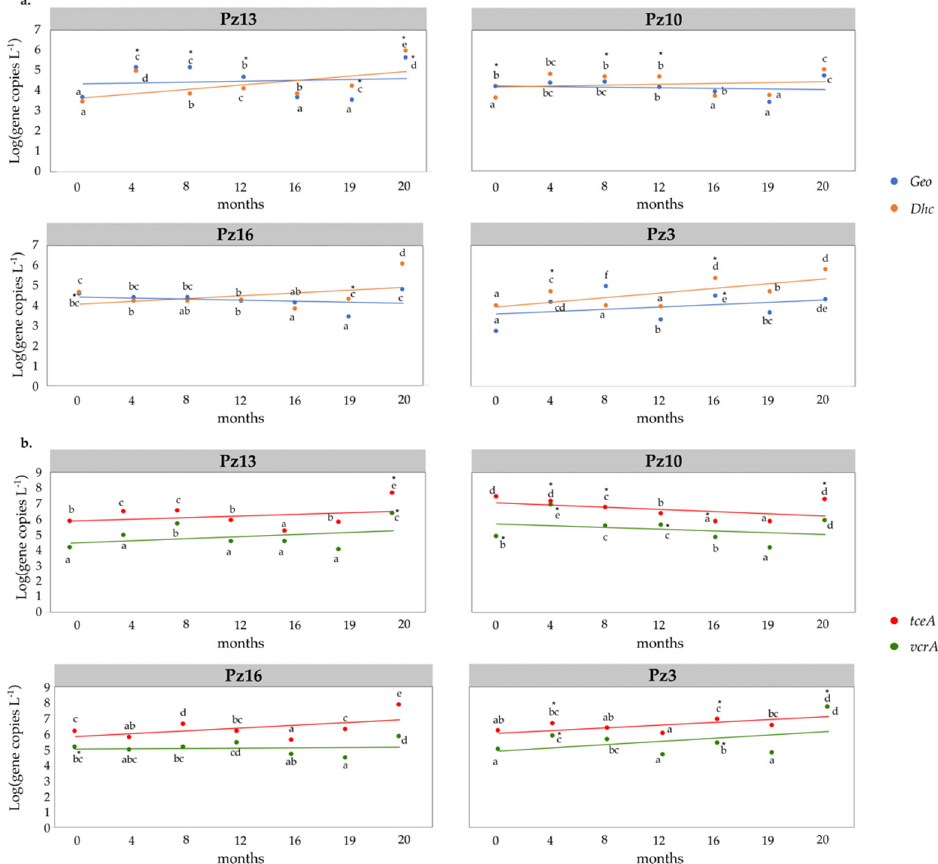
Figure 5. Gene copy abundance of phylogenetic gene markers for Geobacteraceae ( Geo ) and Dehalococcoides ( Dhc ) ( a ) and functional gene markers ( tceA and vcrA ) ( b ) in Pz13, Pz10, Pz16 and Pz3 during time. * indicates significant difference between piezometers of transect upstream and downstream injection wells of anaerobic bio-barrier. Lowercase letters indicate significant or not significant difference between different time (Tukey’s test, p ≤ 0.05).